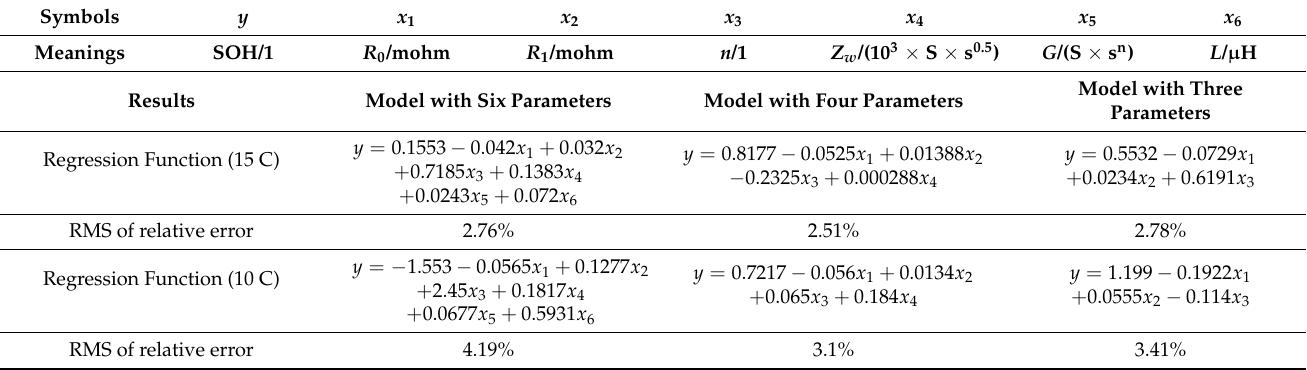
Table 2. Results of the regression model (EIS